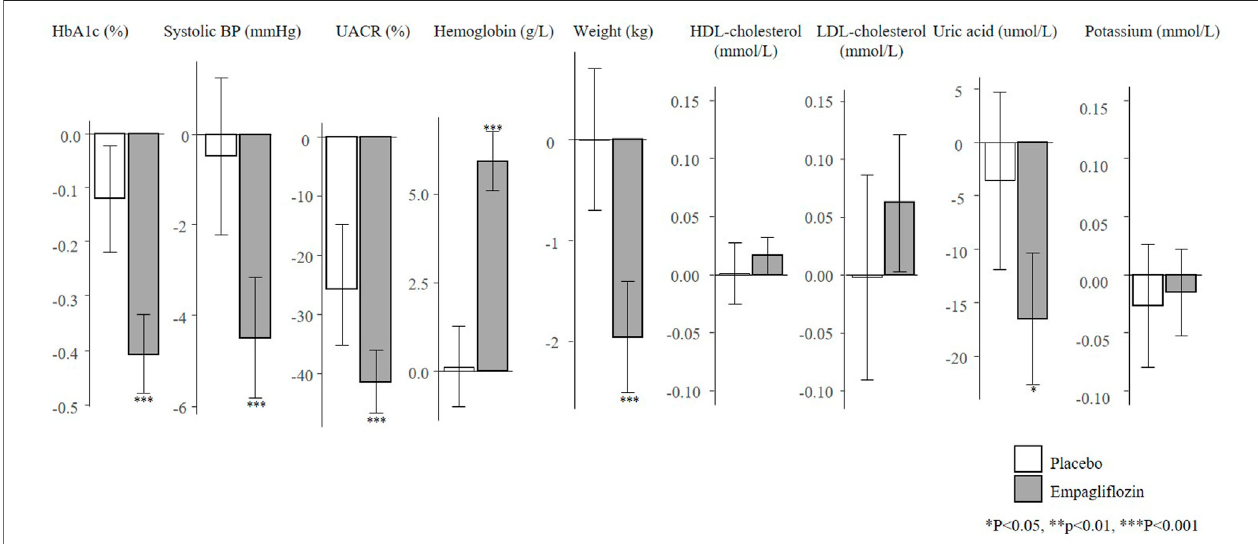
FIGURE 5 | Predicted risk change for the composite kidney or cardiovascular death outcomes in the ongoing EMPA-KIDNEY trial based on single risk marker changes as well as the PRE score. The estimation of risk change was performed in a subset of the EMPA-REG OUTCOME trial population ful fi lling the EMPA-KIDNEY trial inclusion criteria (N (cid:1) 1222). HbA1c, glycated hemoglobin; BP, blood pressure; UACR, urinary-albumin-creatinine-ratio; HDL, high-density-lipoprotein; LDL, low-density-lipoprotein; PRE score, Parameter Response Ef fi cacy score.